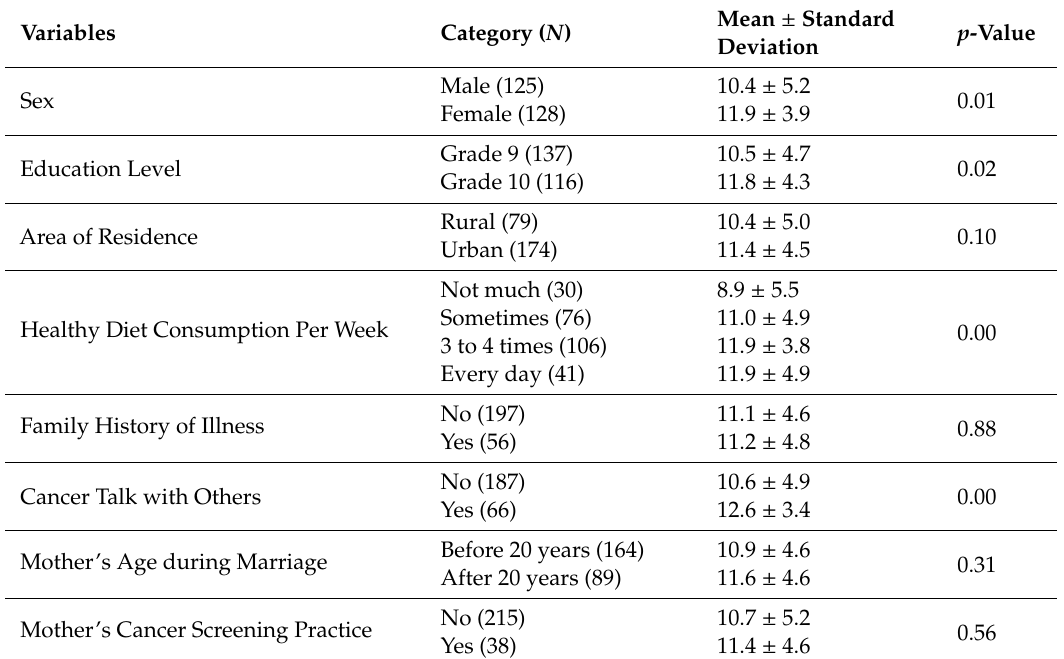
Table 1. Relationship between the demographic variables of students and the total cervical cancer knowledge score.